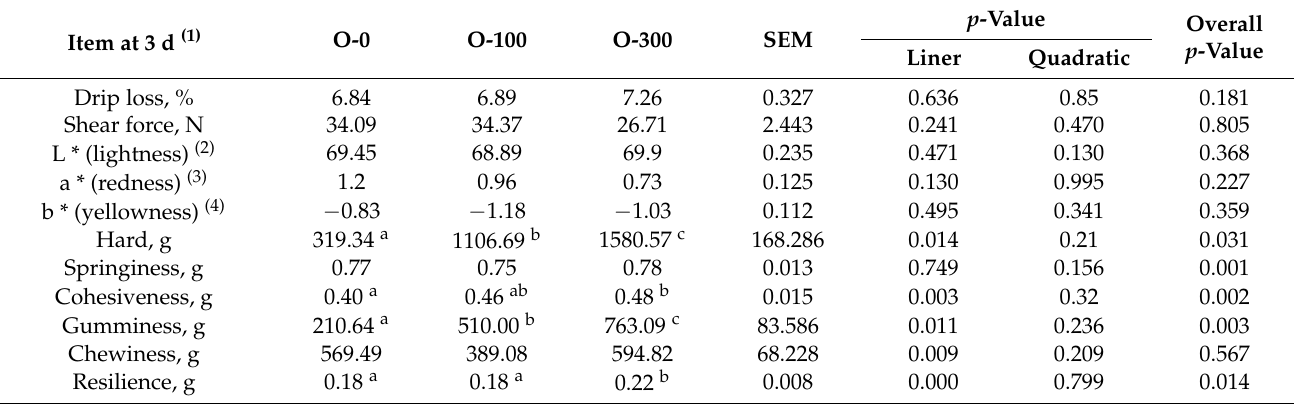
Table 5. The effect of LL supplementation on meat quality of finishing pigs.